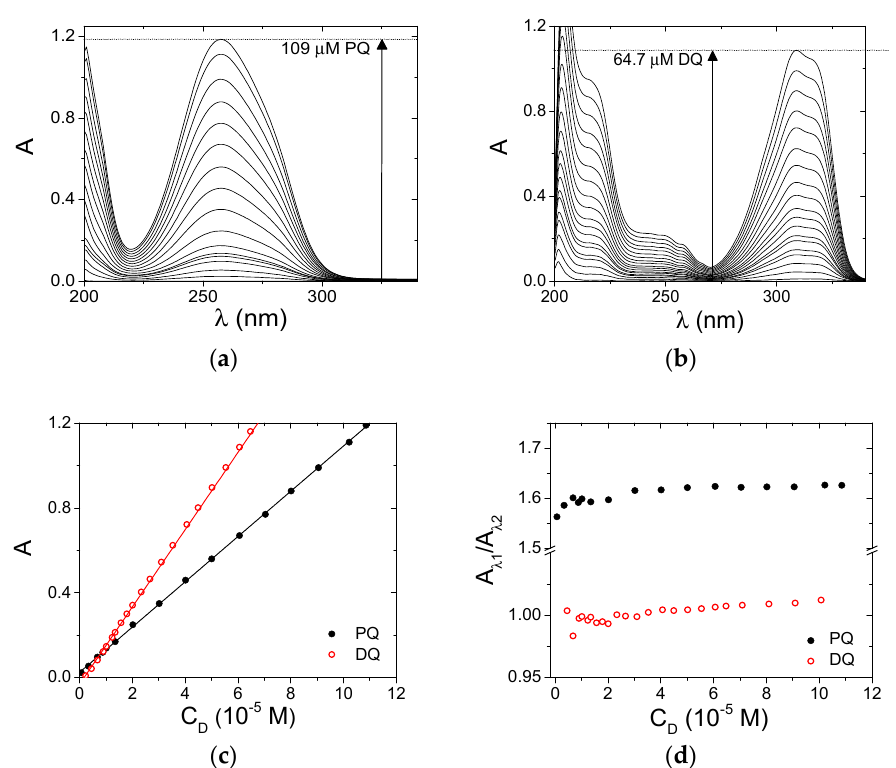
Figure 2. Spectroscopic characterization of PQ and DQ, NaCl 0.1 M, NaCac 2.5 mM, pH 7.0, 25.0 °C. ( a ) PQ from 4.08 × 10 − 7 to 1.09 × 10 − 4 M; ( b ) DQ from 2.26 × 10 − 7 to 6.47 × 10 − 5 M; ( c ) relevant Lambert–Beer plots (full mark is PQ at 258 nm ε = 1.07 × 10 4 M − 1 cm − 1 ; open mark is DQ at 309 nm ε = 1.82 × 10 4 M − 1 cm − 1 ; ( d ) absorbance ratio plots (PQ full mark, A258 nm/A280 nm; DQ open mark, A297 nm/A324 nm.